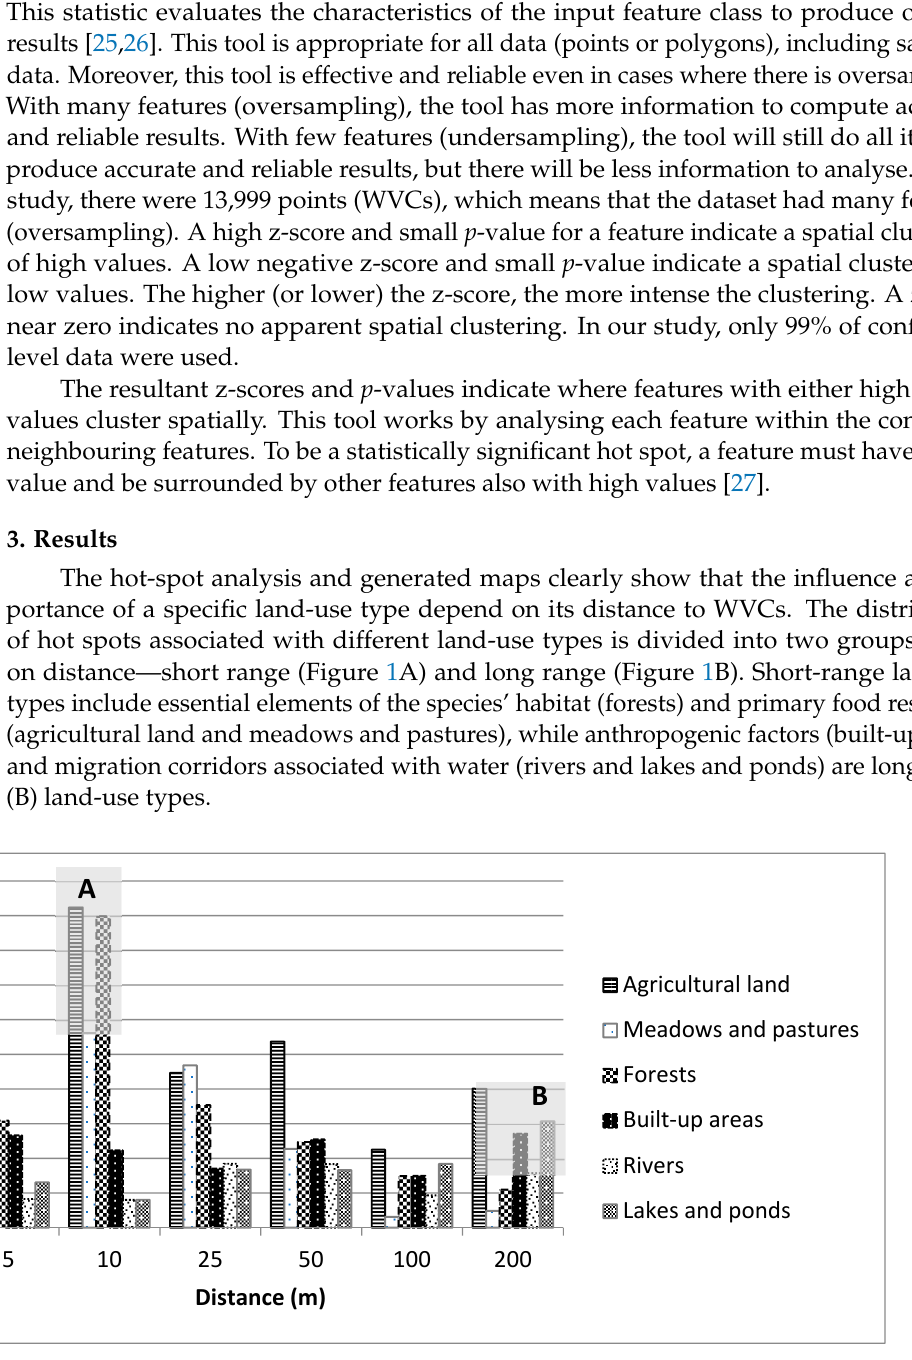
Figure 1. Total number of hot spots and distance to different land-use types: ( A ) short-range sensitive land-use types and ( B ) long-range sensitive land-use types.